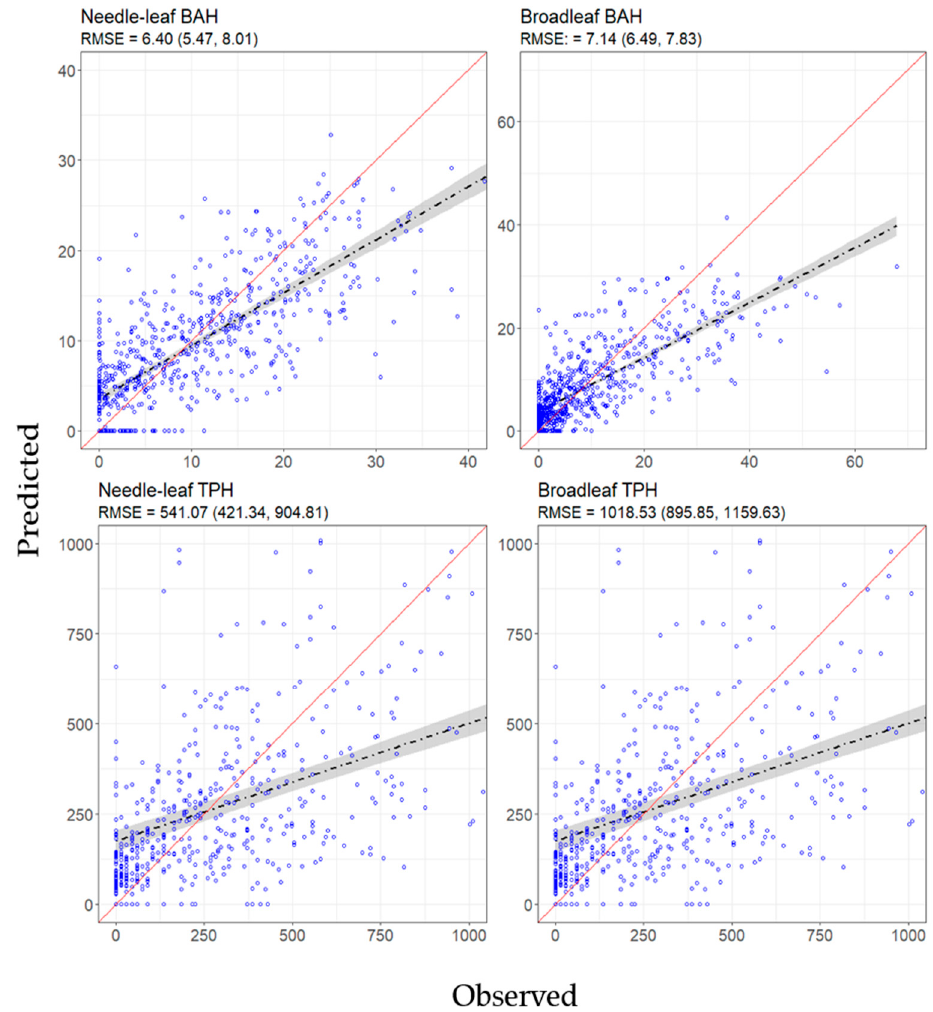
Figure 7. Scatter plot of predicted (y-axis) vs observed (x-axis) values for basal area per ha (BAH) and trees per ha (TPH) hurdle models. Root mean squared error (RMSE) and bootstrapped estimates of lower and upper 95% RMSE confidence limits (within parentheses) are reported beneath each graphic’s title. The black dashed line and gray region surrounding that line depict the linear relationship and corresponding 95% confidence band between predicted and observed values. The solid red line is a one-to-one line and provides a benchmark for comparison.